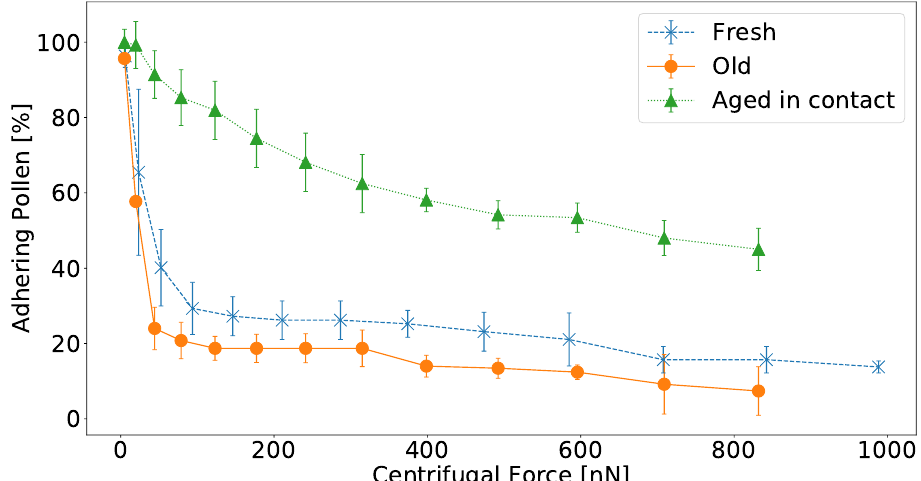
Figure 2. Quantification of Hypochaeris radicata pollen adhesion to glass using centrifugation. The amount of adhering pollen grains—relative to the number of pollen prior to centrifugation—is computed versus the centrifugal force. The adhesive properties were analyzed for pollen grains that were (1) fresh (blue crosses, n = 115); (2) old (orange circles, n = 165) when being deposited on the glass slide; and (3) were deposited freshly, but aged in contact with the glass prior to centrifugation (green triangles, n = 122). The mean values of four individual experiments are presented for each group of pollen and errorbars correspond to the standard deviation. Pollen that aged in contact with the glass adhered strongest to it. Fresh pollen grains had stronger adhesion than old